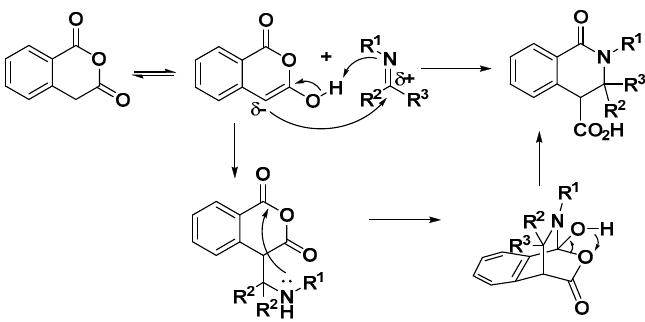
Figure 1. Synthesis of tetrahydroisoquinolonic (THIQ) acids via the Castagnoli–Cushman reaction and its mechanism.